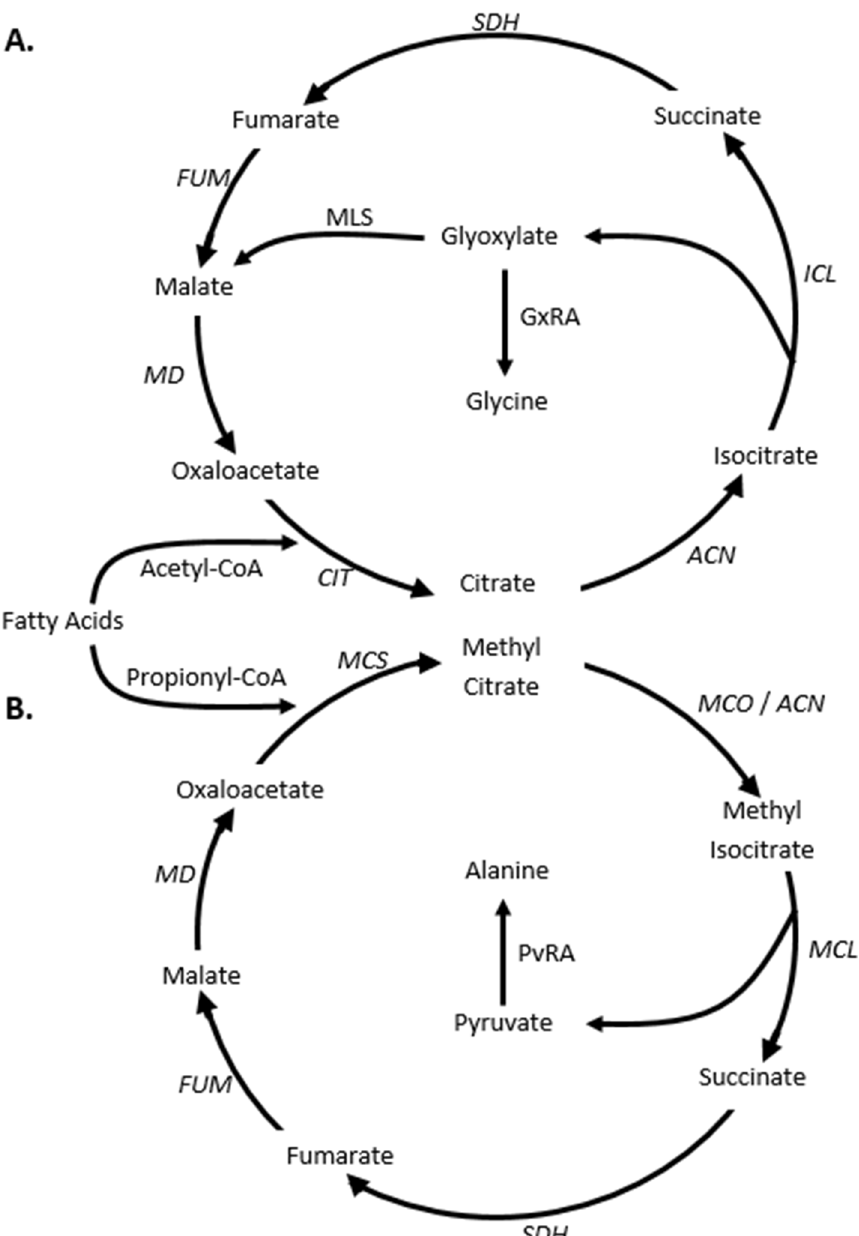
Fig 1. Interaction of Ald with two metabolic pathways. Even-chain fatty acids are degraded to acetyl-CoA while odd-chain fatty acids also produce propionyl-CoA. Acetyl-CoA is oxidized by the (A) glyoxylate cycle and propionyl-CoA by the (B) methylcitrate cycle. Enzyme activities are indicated in italics. ACN – aconitase; ICL – isocitrate lyase; MLS – malate synthase; MD – malate dehydrogenase; CIT – citrate synthase; SDH